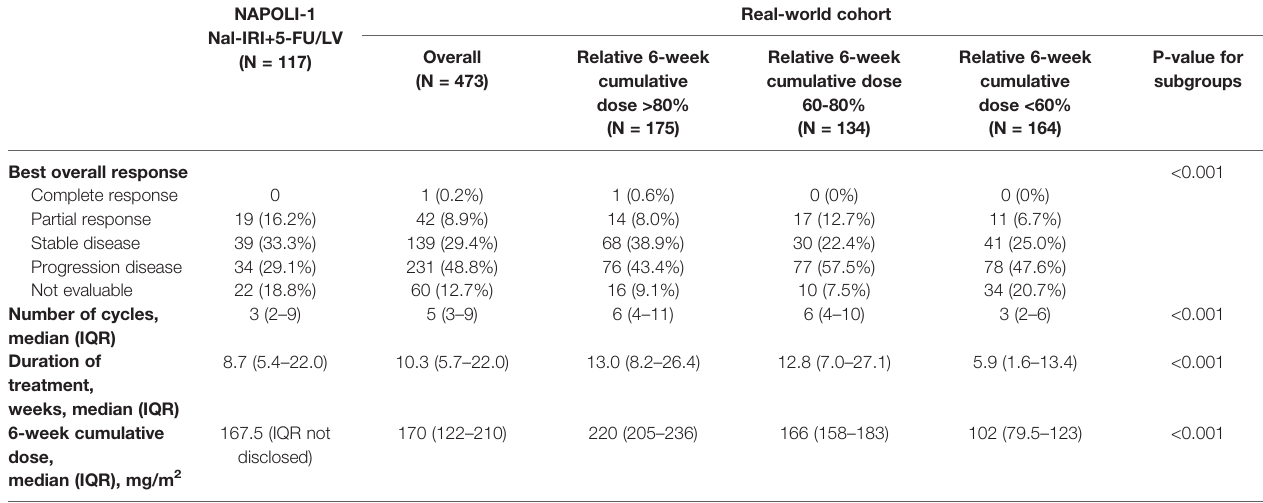
TABLE 2 | Treatment response and